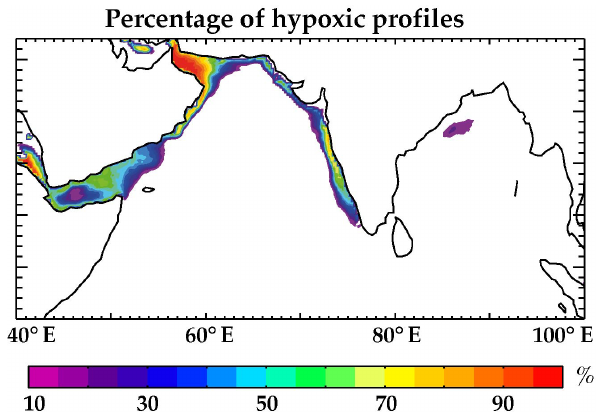
Figure 14. Percentage of the occurrence of near-surface hypoxic conditions in the model during fall. Near-surface hypoxic condi- tions are defined as profiles with an oxygen concentration below 80µmolL − 1 (a threshold under which most large marine organisms suffer from stress) in the upper